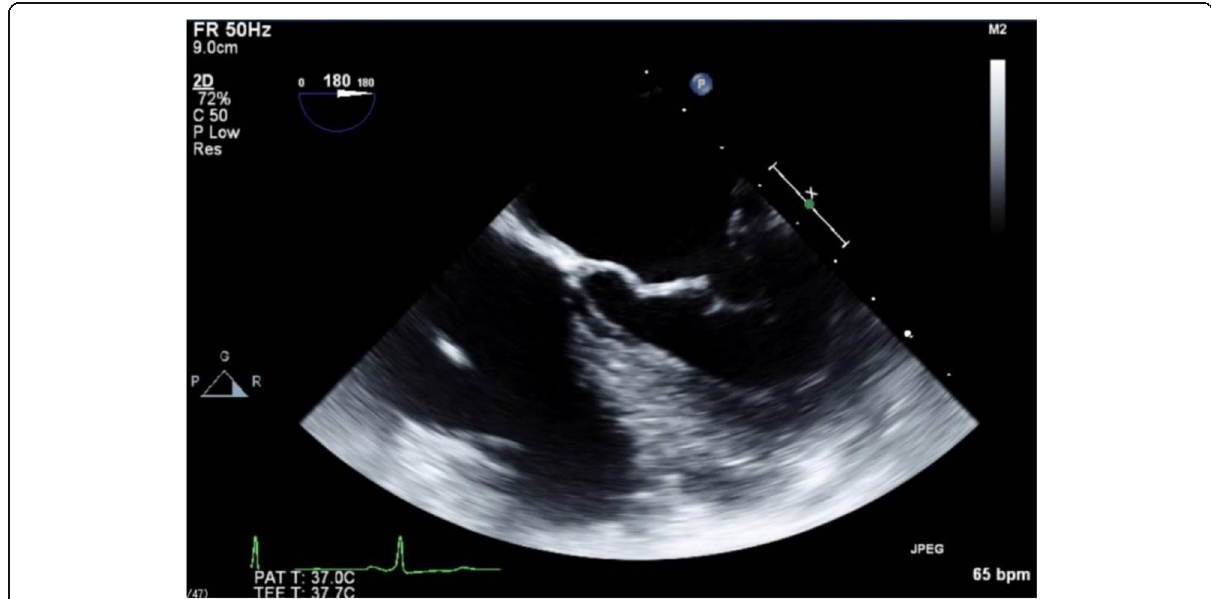
Fig. 3 The ME 4-chamber view, which is obtained at a